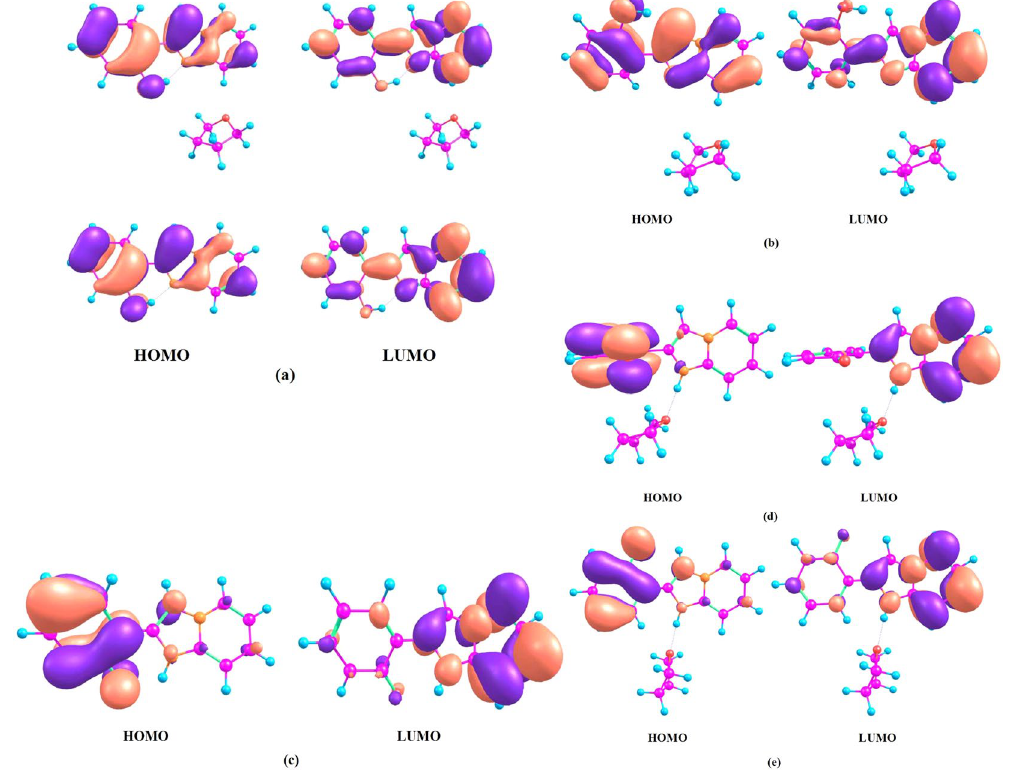
Figure 11. The visual electron population of the frontier molecular orbitals HOMO and LUMO for ( a ) the cis- HPIP in the mixed liquid and PCM solvation, ( b ) np-HPIP, ( c ) ik-HPIP, ( d ) v-HPIP and ( e ) trans-k-HPIP.